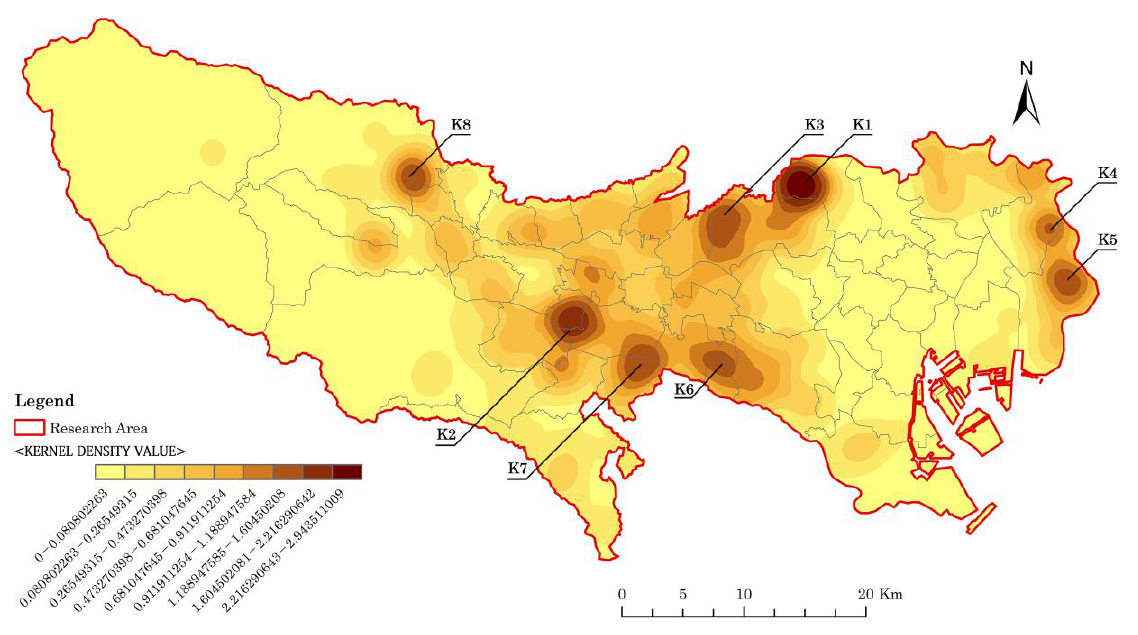
Figure 12. Kernel Density Estimation. “K1” to “K8” represent AGs’ clusters.